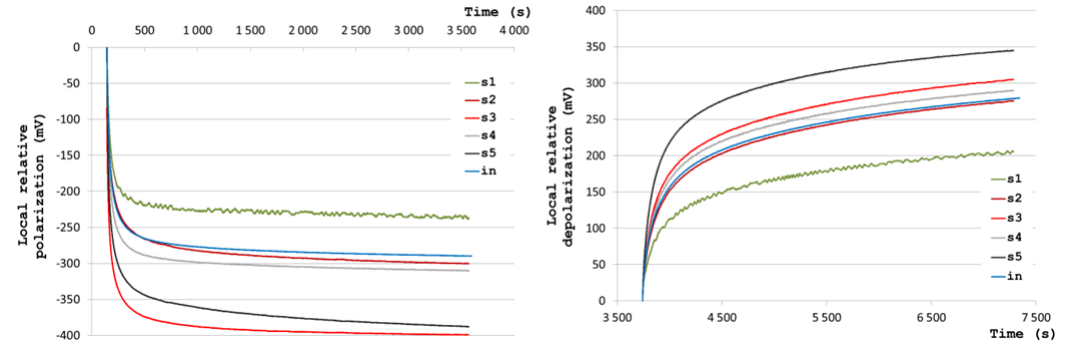
Figure 4. Local relative polarization (left) and depolarization (right) time